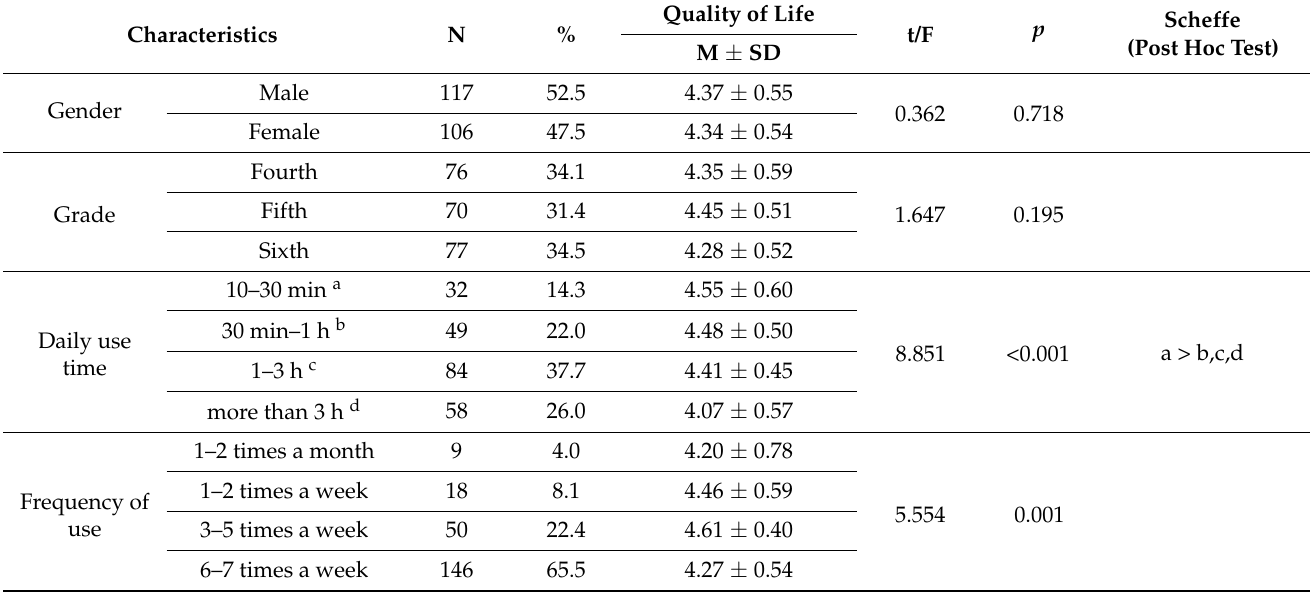
Table 1. Differences in quality of life by general characteristics (n =